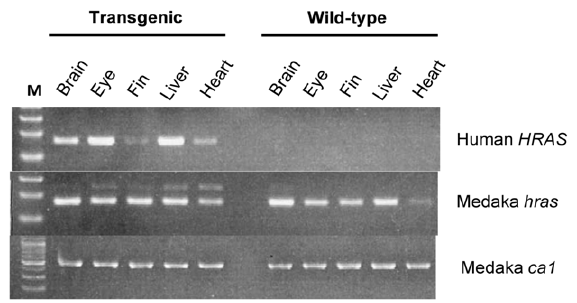
Figure 2. Double-transgenic medaka expresses human HRAS G12V . Total RNA isolated from the indicated tissues both of Tg(tyr:HRAS G12V ) / Tg(hsp:cre) double-transgenic medaka at 8 mpf (with heat treatment at 4 wpf) and of wild-type medaka was subjected to RT- PCR analysis of human HRAS and medaka hras . Transcripts of the medaka cytoplasmic actin gene ( ca1 ) were examined as an internal control of RNA quality. Lane M, DNA size markers.